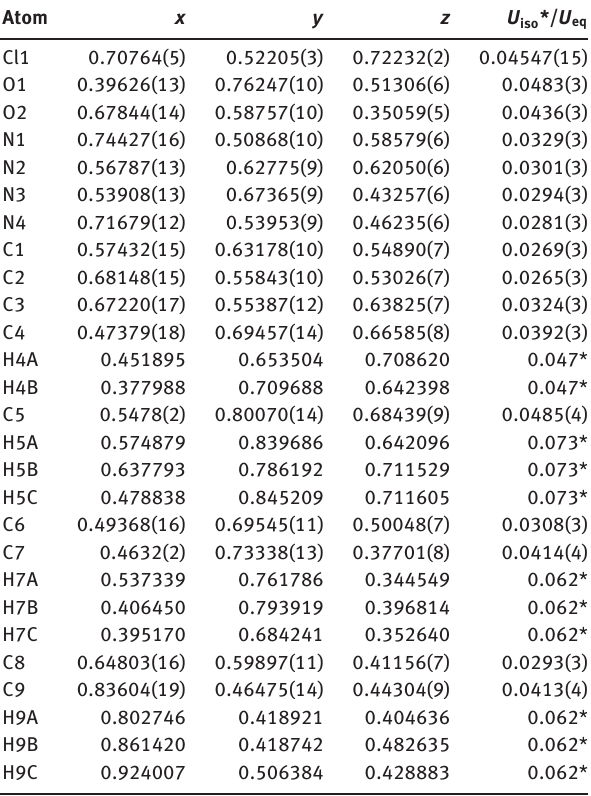
Table 2: Fractional atomic coordinates and isotropic or equivalent isotropic displacement parameters (Å 2 ).